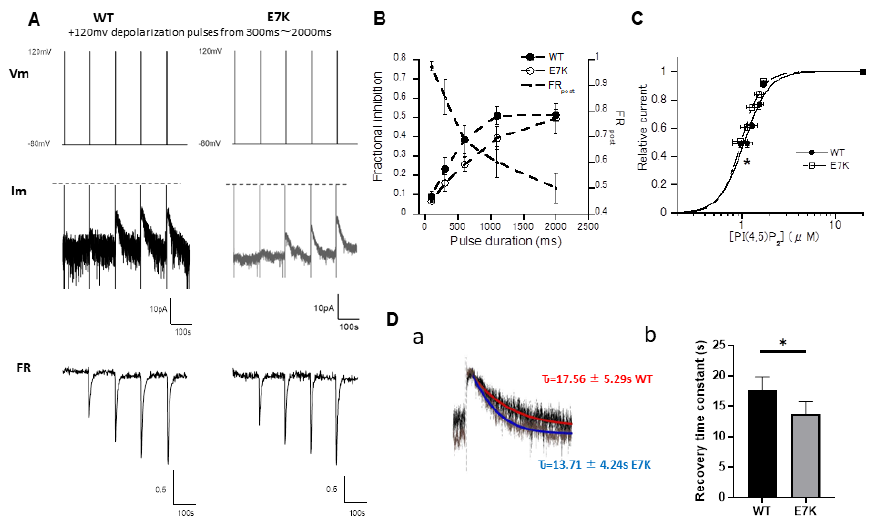
Figure 3. Quantitative relationships between endogenous PIP 2 level and whole-cell TRPM4 current amplitude for WT and E7K mutant. ( A ) Graded depletion of endogenous PI(4,5)P 2 was attained by applying a set of depolarizing pulses of incremental duration (300–2000 ms; from − 60 to 120 mV). To minimize time-dependent changes due to desensitization, a relatively low concentration of Ca 2+ (1 µ M) was included in the pipette to induce TRPM4 currents under the whole-cell conditions. The tree panels in the figure denote the simultaneously recorded whole-cell TRPM4 current (I m ) and concomitant FRET ratio (FR) in response to depolarizing pulses of incremental duration (300–2000 ms; V m ). Prolongation of depolarizing pulses resulted in the progressive inhibition of whole-cell TRPM4 currents, the extent of which was greater for WT than E7K, despite the same degree of FR decrease (i.e., PIP 2 depletion). ( B ) Duration-dependent inhibition of the whole-cell TRPM4 current by depolarization-induced PIP 2 depletion for WT and E7K (open vs. filled circles). The duration-dependent inhibition is defined by using the ratio of TRPM4 current amplitudes before (I pre ) and after (I post ) each depolarization according to the formula: fractional inhibition = 1 − I post /I pre , which is plotted against the pulse duration. FR change is also displayed together (dashed curve). ( C ) The relationships between endogenous PIP 2 concentration and WT- or E7K-TRPM4 channel activity (normalized whole-cell current amplitude). Endogenous PIP 2 concentration was estimated from the FR value after the previous study [16] according to the formula: FR ≈ F 2 = 1/ 1 + K d [ PI ( 4,5 ) P 2 ] FR max , where FR max was determined from PIP5K-overexpressing cells as a 1.2-fold higher value than that evaluated from the control cells[16]. The apparent K d values of PI(4,5)P 2 binding to WT- TRPM4 channels and E7K-mutant TRPM4 channels determined by this method were 1.06 ± 0.05 μM and 0.97 ± 0.02 μM, respectively. *: p < 0.05 with ANOVA followed by Tukey’s post hoc tests ( n = 5). ( D ) Time courses of the whole-cell TRPM4 currents recovering from depolarization-induced, DrVSP-mediated inhibition for WT (red curve in a) and E7K (blue curve in a). The time constant of recovery (τ) was determined by mono-exponential fitting, which resulted in values of 17.56 ± 5.29 and 13.71 ± 4.24 s for WT and E7K, respectively (b). *: p < 0.05 with unpaired t-test, respectively ( n = 5).